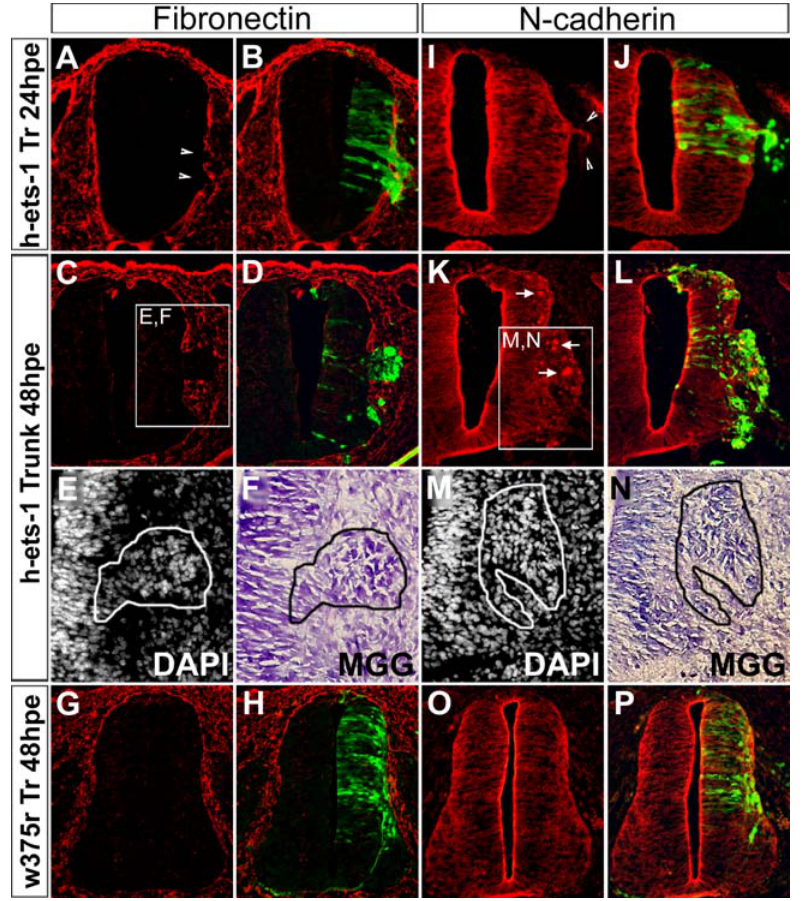
Figure 8. Ets-1Misexpression Promotes Delamination without Inducing Epithelium to Mesenchyme Transition. (A–P) Analysis of the effects of h- ets-1 misexpression in intermediate to ventral neural tube at trunk levels at 24hpe (A–B, I–J) and 48hpe (C–H, K–P). Transversal cryosections (10 m m) labeled by immunofluorescence with anti-Fibronectin (A–D, G–H), anti-N-cadherin (I–L, O–P) antibodies, by DAPI incorporation (E, M) and by histological staining with May-Gru¨nwald Giemsa (MGG) (F, N). H-ets-1 electroporated cells invade the extracellular matrix without producing Fibronectin (A–D, arrow heads) and remain strongly attached to each others by N-cadherin (I–L, arrow heads) at 24hpe (A–B, I–J) and 48hpe (C–D, K– L). Accumulations of N-Cadherin are observed within the core of the ectopic clusters at 48hpe (K–L, white arrows). Nuclear detection (E, M) and histological staining (F, N) of sections presented in (C) and (K) confirm the high cellular density in the ectopic clusters (E–F, M–N, white and black lines). Cells transfected by w375r exhibit normal behavior (G–H, O–P). Tr, trunk.